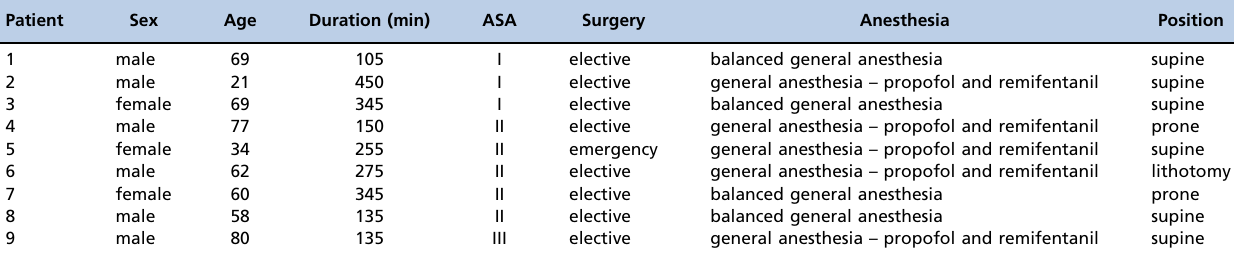
Table 1 - Patient